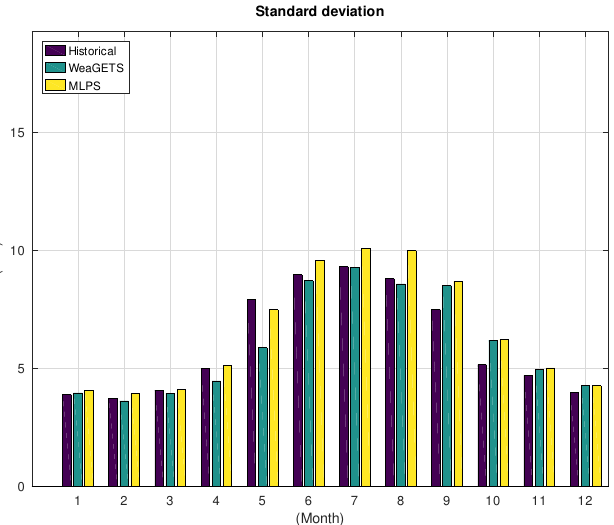
Figure 3. Monthly standard deviation of the synthetic time series (WeaGETS and MLPS) and historical values of the Hohenpeissenberg weather